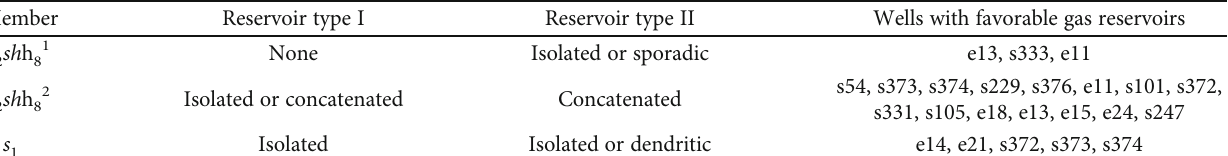
Table 5: Distribution patterns for various reservoir types in the Su-54 block of the western Sulige gas fi eld. Member